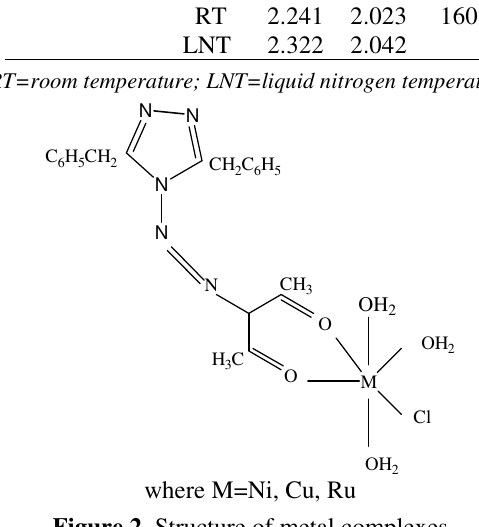
Figure 2. Structure of metal